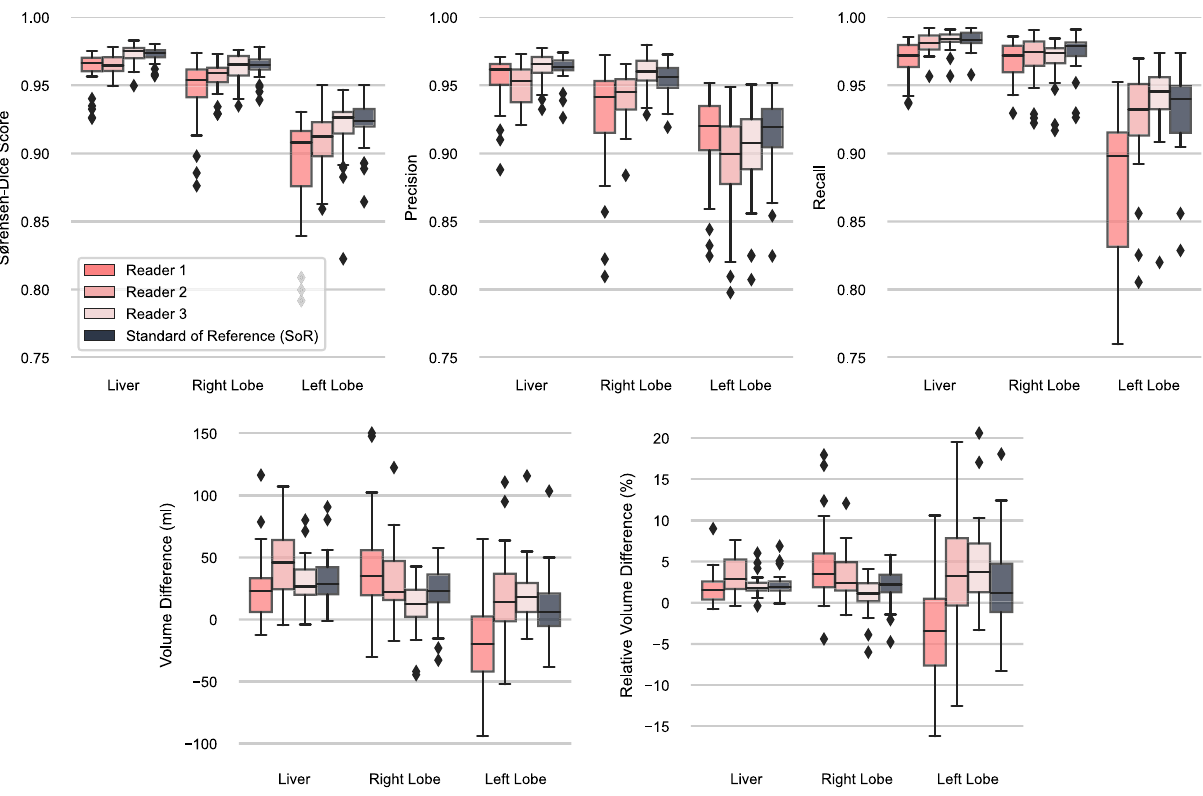
Figure 4. Evaluation of the trained model ensemble on the test dataset. Each CT scan was annotated by three different readers and additionally a standard of reference was created by majority